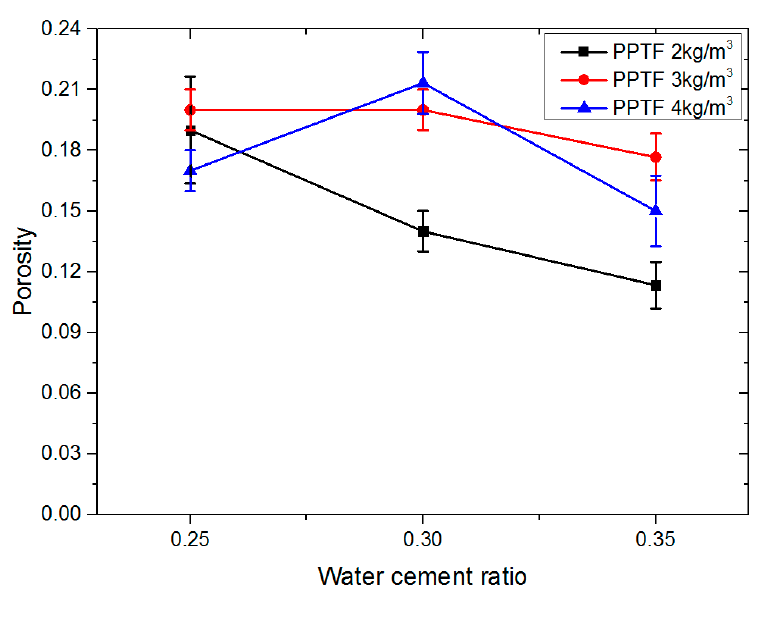
Figure 5. Influence of water-cement ratio on permeability of pervious concrete.